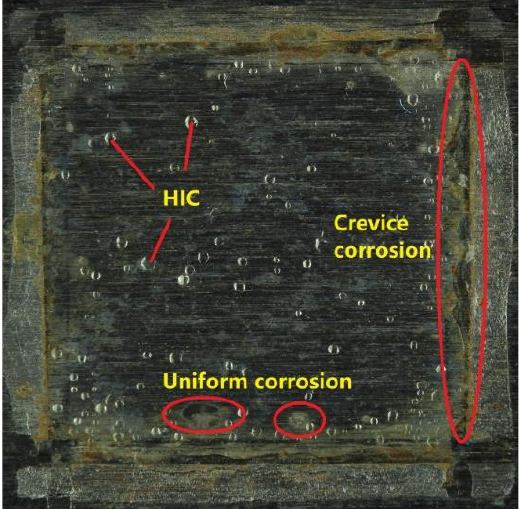
Figure 5. Observation of HIC area surface after tests .